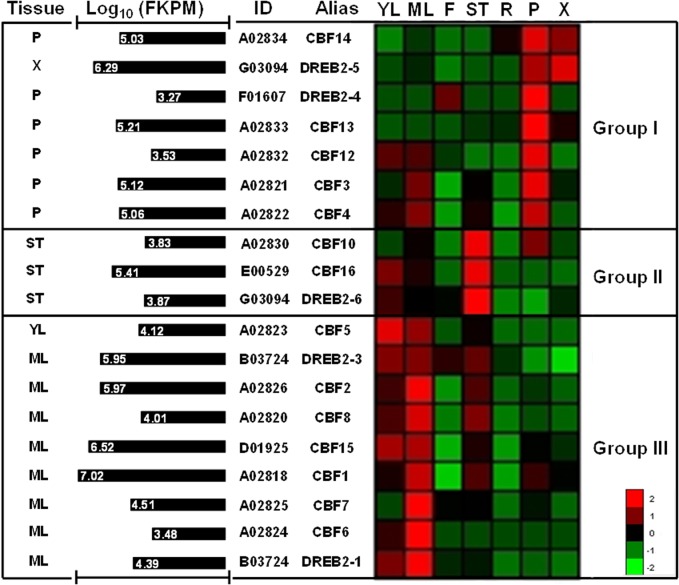

CBF and DREB2 gene expression profiles from RNAseq data corresponding to various tissues from E. grandis.Raw expression data were obtained from the Eucalyptus genome integrative explorer (http://eucgenie.bi.up.ac.za). Expression analysis is presented for 14 EgrCBF and five EgrDREB2 genes which were automatically annotated, but do not concerns the four additional CBF genes which were manually annotated in our hands. Gene name and accession numbers are mentioned respectively in Alias and ID columns. Heat map and hierarchical clustering of gene expression profiles (right panel) were performed by using expander software (ACGT, http://www.cs.tau.ac.il). For each gene, the highest absolute expression value (Log10 FKPM) is represented in the left panel with the indication of corresponding tissue. YL, young leaves; ML, mature leaves; F, flowers; ST, shoot tips; R, roots P, phloem; X, xylem.